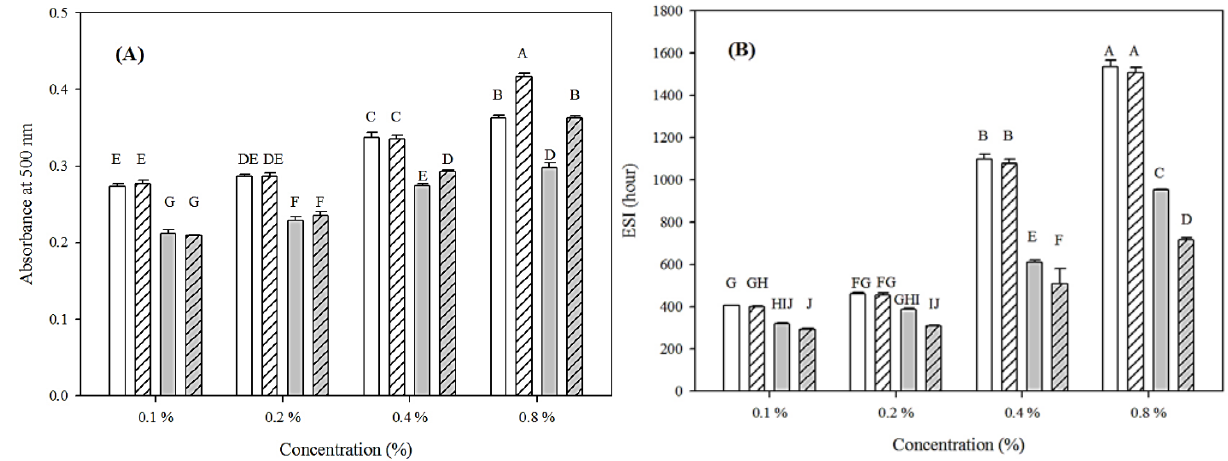
Figure 6. The ( A ) absorbance at 500 nm and ( B ) emulsifying stability index (ESI) of chia seed mucilage extracted by ultrasound in combination with heat at different concentrations. Error bars represent standard deviations. Means with different superscript capital letters denote significant difference ( p < 0.05). Figure 5. The water holding capacity (WHC, ) and oil holding capacity (OHC, ) of chia seed mucilage extracted by ultrasound in combination with heat. Error bars represent standard deviations. Means with different superscript capital letters and lowercase letters denote significant difference among WHC and OHC ( p < 0.05), respectively.